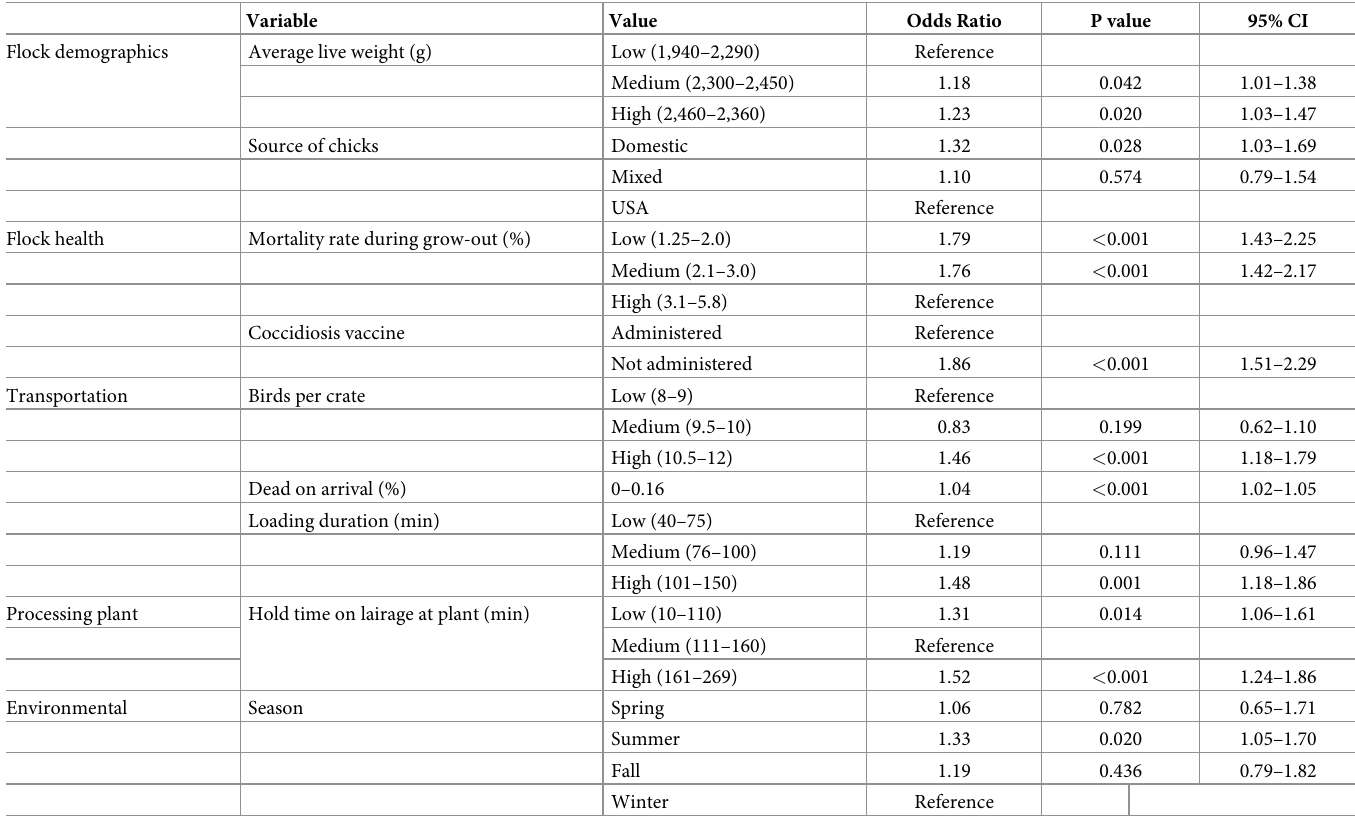
Table 5. Results of the final random intercept 2-level (flock-fillet) multivariable regression model for woody breast, in a cohort of 9,250 chicken breast fillets col- lected at two processing plants between 2019–2020 in Ontario, Canada (n = 9,250